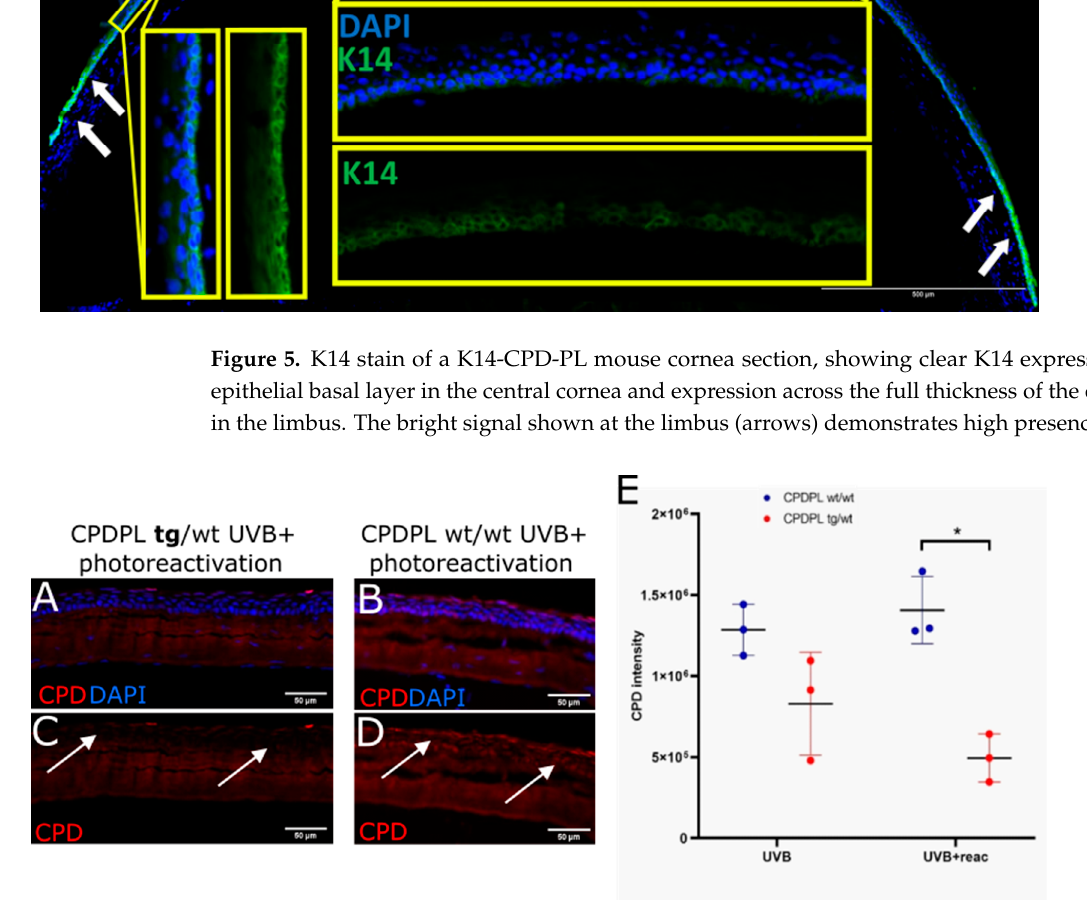
Figure 6. Representative immunofluorescence images illustrating recovery of CPDPL mutant mice fol- lowing UVB exposure and photoreactivation. Merged images ( A , B ) show nuclei stained blue (DAPI) and CPDs stained red (positive nuclei indicated by arrows in ( D ) and absence of signal indicated by arrows in ( C ). ( E ) Mean fluorescence measurements were taken after 1 J/cm 2 UVB and 30 min photoreactivation. CPD immunofluorescence was highest in irradiated as well as photoreactivated wt/wt (* is p < 0.05). Each data point was analyzed from 3 technical